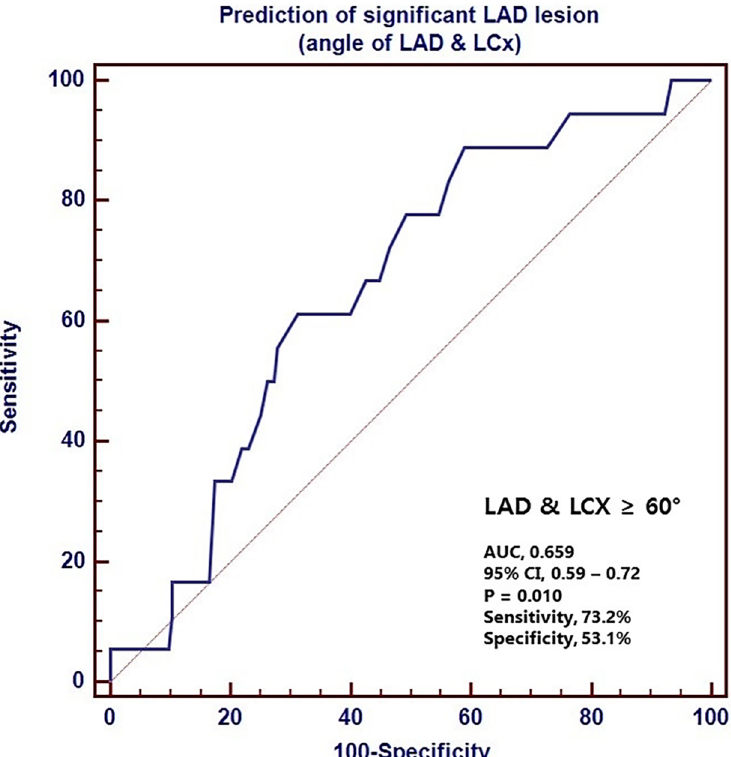
Figure 6. The receiver operating characteristic (ROC) curve for the LAD-LCx angle in the prediction of LAD stenosis. The area under the curve is 0.659. LAD—left anterior descending, LCx—left circumflex, CI—confidence interval. Reprinted with permission under the open access from Moon et al. [15] 2018, Public Library of Science.